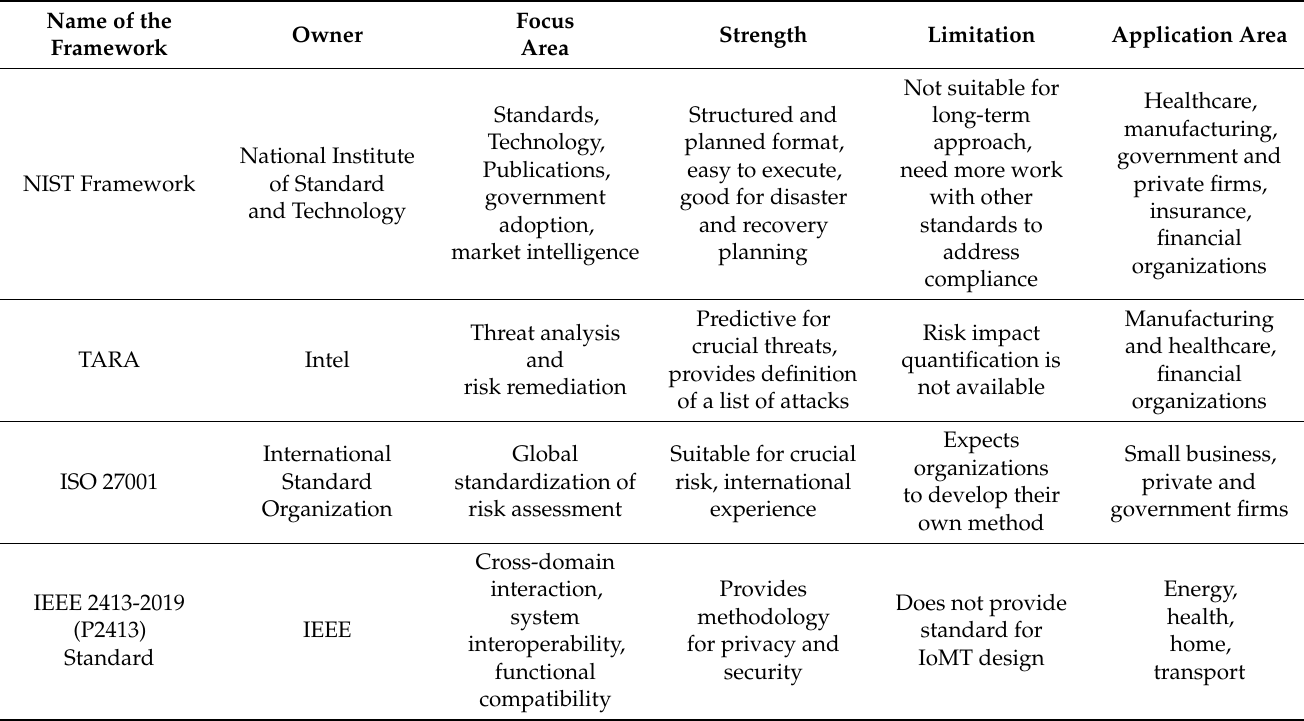
Table 3. Summary of existing frameworks.